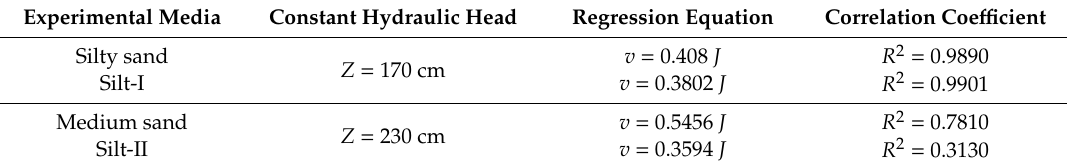
Figure 4. Linear fitting diagrams of average velocity ( v ) versus hydraulic gradient ( J ) of four media: ( a ) silty sand, ( b ) silt-I, ( c ) medium sand, and ( d ) silt-II. Note that the silty sand and silt-I were used under the constant hydraulic head of 170 cm, while the medium sand and silt-II were used under the constant hydraulic head of 230 cm. The black line represents a linear fitting curve. Table 3. Linear fitting equations and correlation coe ffi cients of experimental